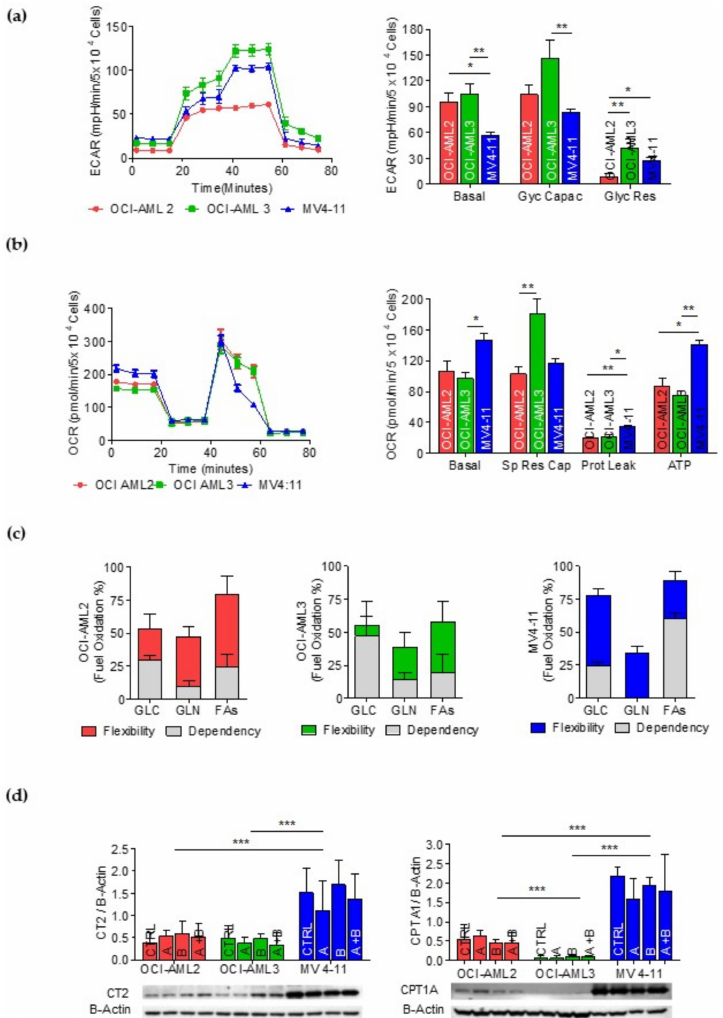
Figure 2. Metabolic characterization of OCI-AML2, OCI-AML3 and MV4-11 cell lines. ( a ) Profile of the glycolytic activity. Histograms represent basal glycolysis, glycolytic reserve and glycolytic capacity. ( b ) Profile of the mitochondrial activity. Histograms represent basal respiration, spare respiratory capacity, proton leak and mitochondrial ATP. ( c ) Evaluation of the mitochondrial fuel used (pyruvate, glutamine and FAs). Data are presented as mean ± SD. The experiments were conducted in triplicate. Statistical significances were evaluated through Kruskal–Wallis one-way ANOVA and Dunn’s post hoc tests. ( d ) CT2 and CPT1A protein expression in OCI-AML2, OCI-AML3 and MV4-11 cell lines treated with 1 mM of ascorbate (A), 0.1 mM of buformin (B) or ascorbate–buformin combination (A + B). Statistical analysis by Student’s t -test. * p ≤ 0.05; ** p < 0.005; *** p ≤ 0.0005. Table 6. Expression levels of CT2 and CPT1A proteins in AML cell lines.